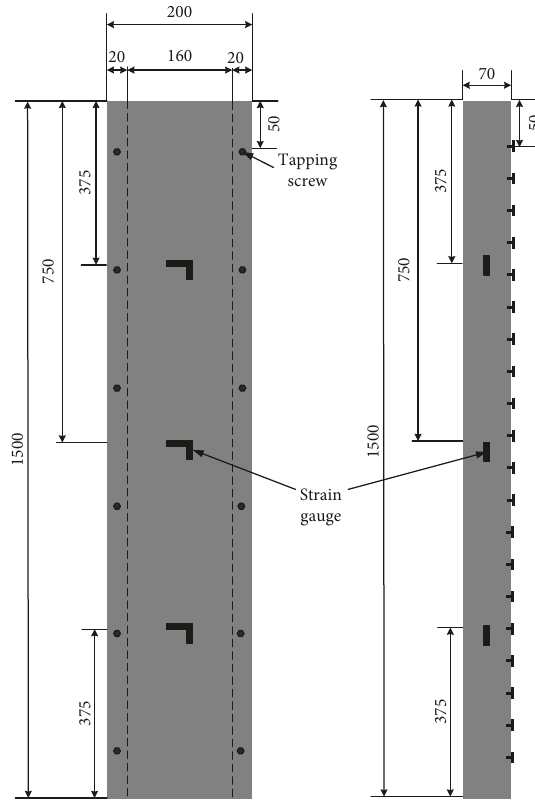
Figure 6: Layout of measuring points of Z200 series (unit: mm).